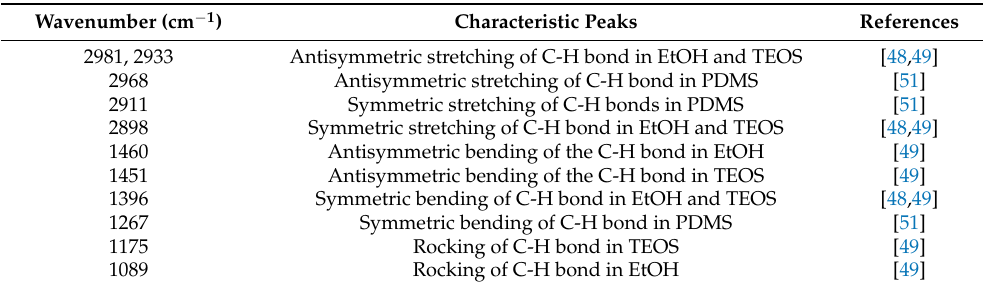
Table 1. Antisymmetric stretching, symmetric stretching, and bending peaks of C-H bonds in TEOS, PDMS, and